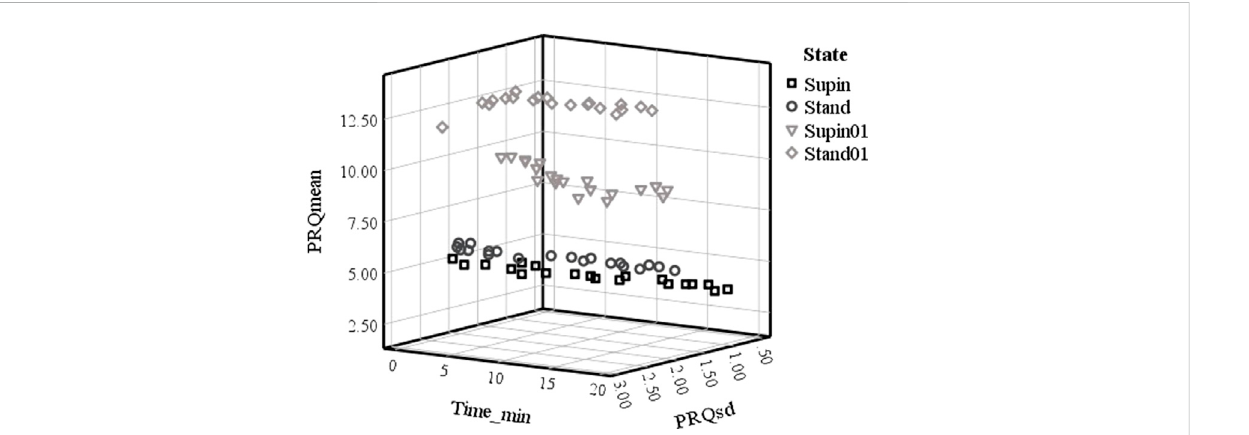
FIGURE 3 Plot of PRQmean versus PRQsd minute values in time in four physiological states in 20 subjects. Supin — supine position with spontaneous breathing, Stand — standing with spontaneous breathing, Supin01 — supine position with slow (0.1 Hz) breathing, Stand01 — standing with slow (0.1 Hz) breathing.